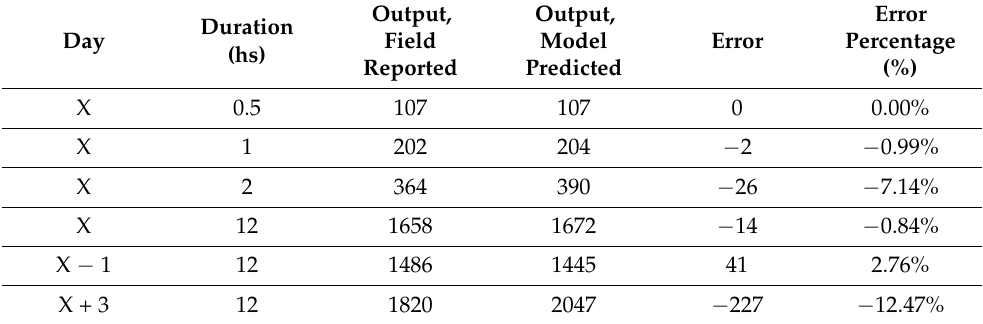
Table 5. The prediction accuracy of the gnLSTM model with a 15 min data training on day